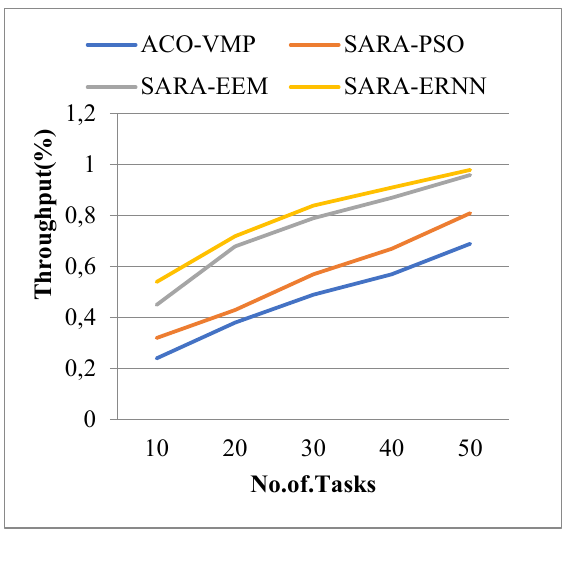
Figure 9. Evaluation performance of throughput of the novel and the available resource allocation